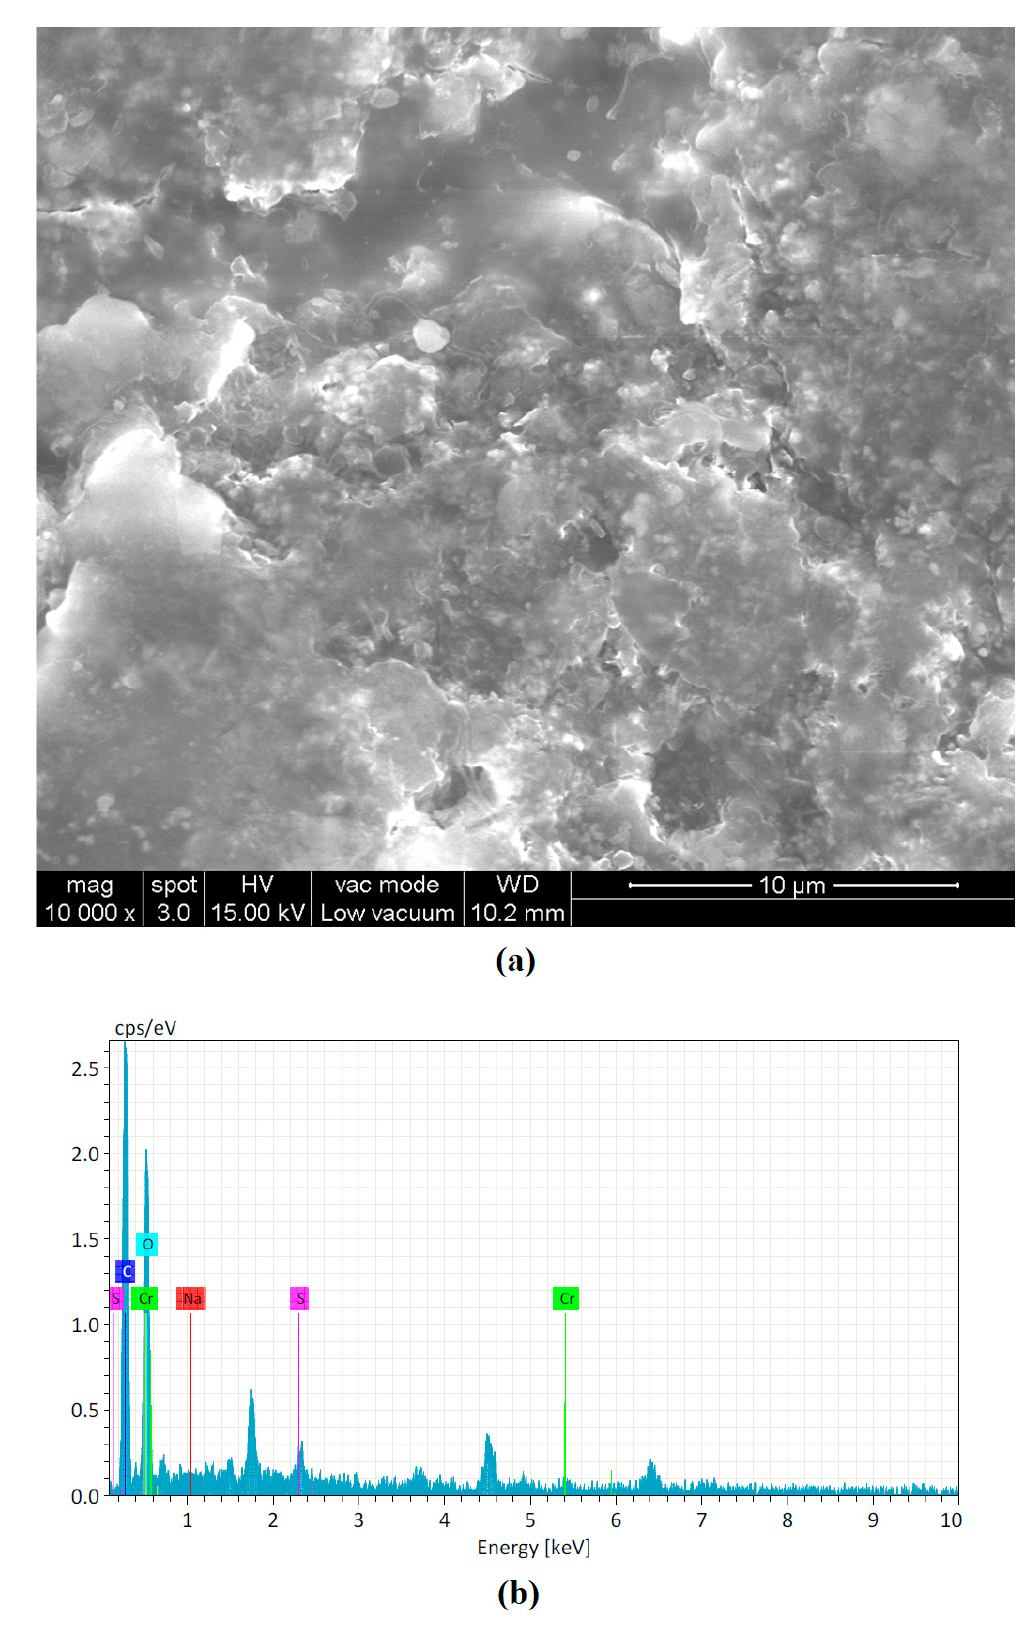
Figure 7. Leather cross-section captured using digital microscope: ( a ) SEM-based surface morphology; ( b ) EDAX analysis.